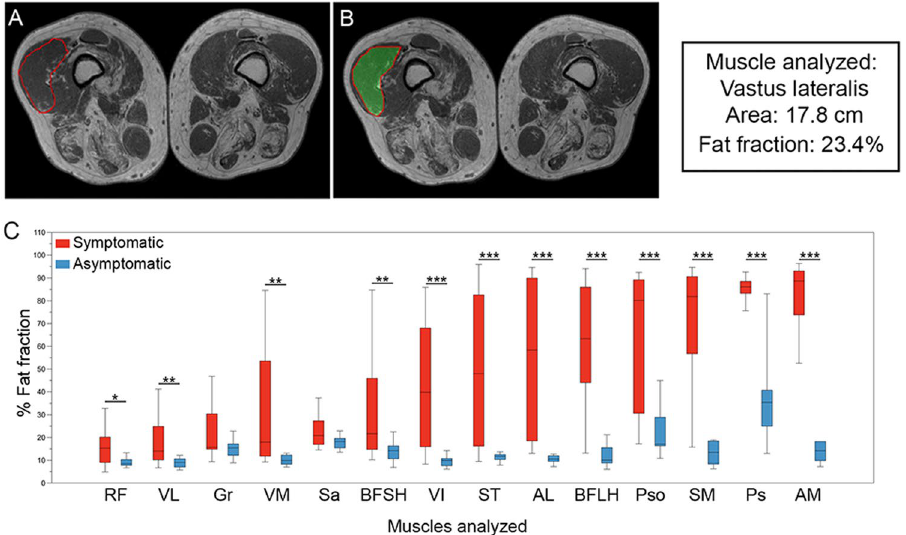
Figure 1. Analysis of fat fraction in thigh and trunk muscles in LOPD patients at baseline. ( A , B ) Show an example of how ROIs are drawn to obtain total muscle area and fat fraction in 3-point Dixon images. ( C ) shows the fat fraction calculated for thigh and trunk muscles in symptomatic (red) and asymptomatic (blue) patients. The box plot includes the 25 th –75 th percentile, the mid lines indicate the median, bars are the 5 th –95 th percentiles. * P < 0.05, ** P < 0.01 and *** P < 0.001. RF: Rectus Femoris , VL: Vastus Lateralis , Gr: Gracilis , VM: Vastus Medialis , Sa: Sartorius , BFSH: Biceps Femoris Short Head , VI: Vastus Intermedius , ST: Semitendinosus , AL: Adductor Longus , BFLH: Biceps Femoris Long Head , Pso: Psoas , SM: Semimembranosus , Ps: Paraspinalis , and AM: Adductor Major .